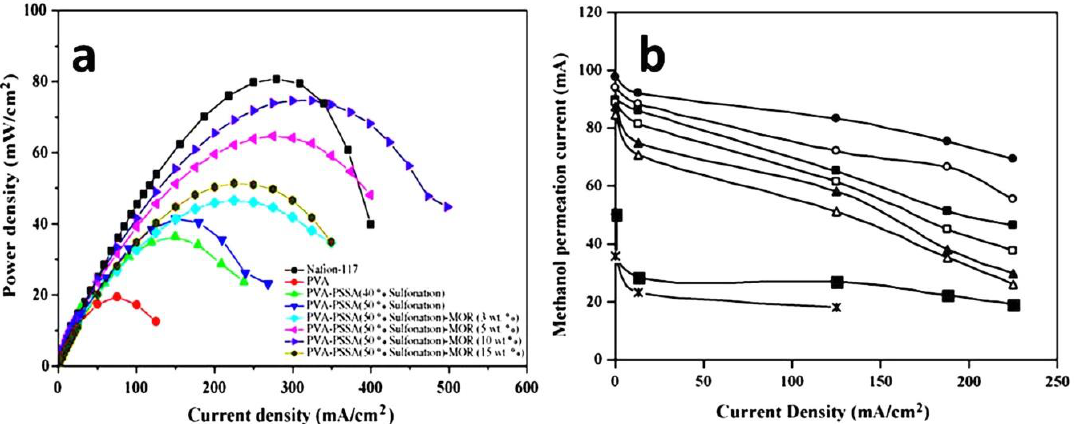
Figure 9. ( a ) Power-density vs. current density for different types of membranes ( b ) Methanol permeability (mA)